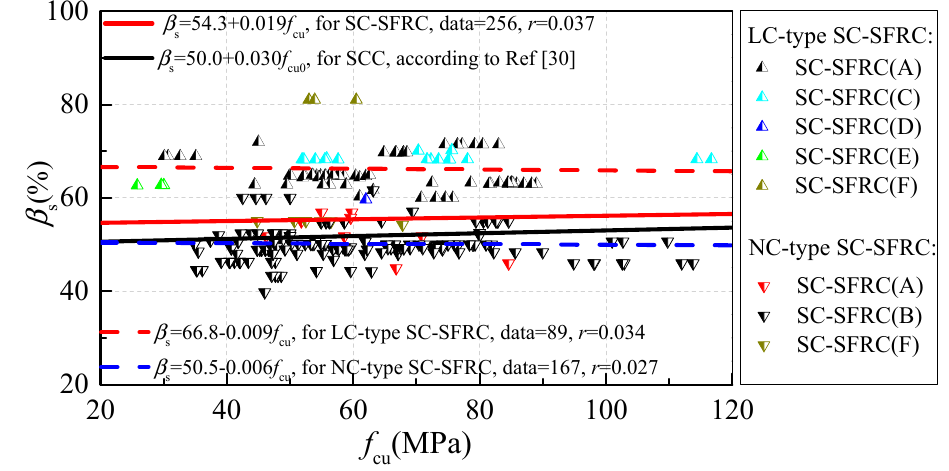
Figure 2. Variation of sand ratio β s along with cubic compressive strength f cu.